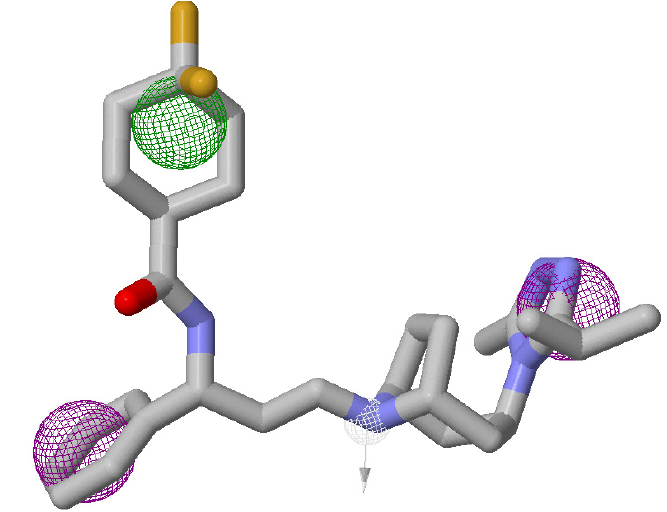
Figure 2. Maraviroc structure used as a template for pharmacophore-based and structural similarity-based compound library generation. Pharmacophore selection criteria—green depicts hydrophobicity, purple depicts aromatic and white depicts hydrogen donor. Arrows indicate that constraints have been